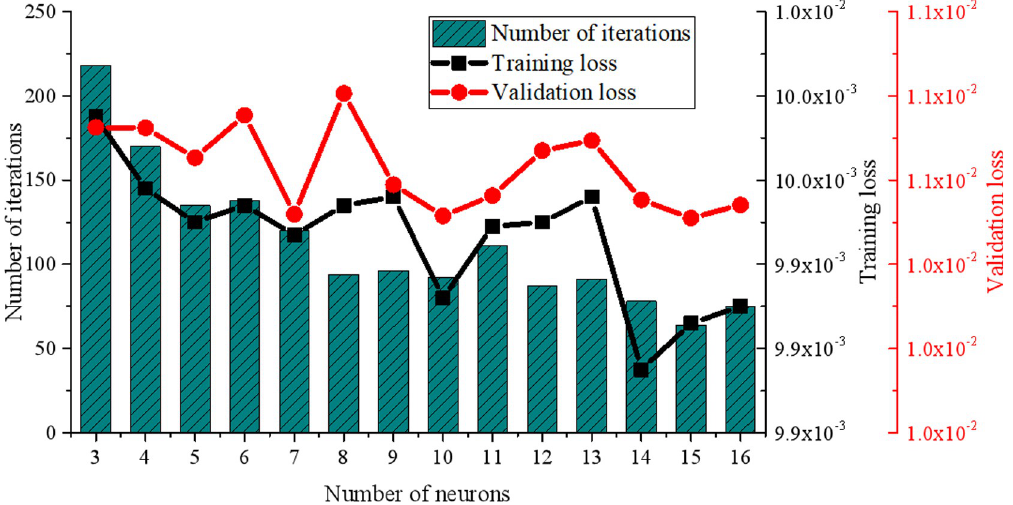
Fig 4. Comparison of training results of different numbers of neurons in the hidden layer.